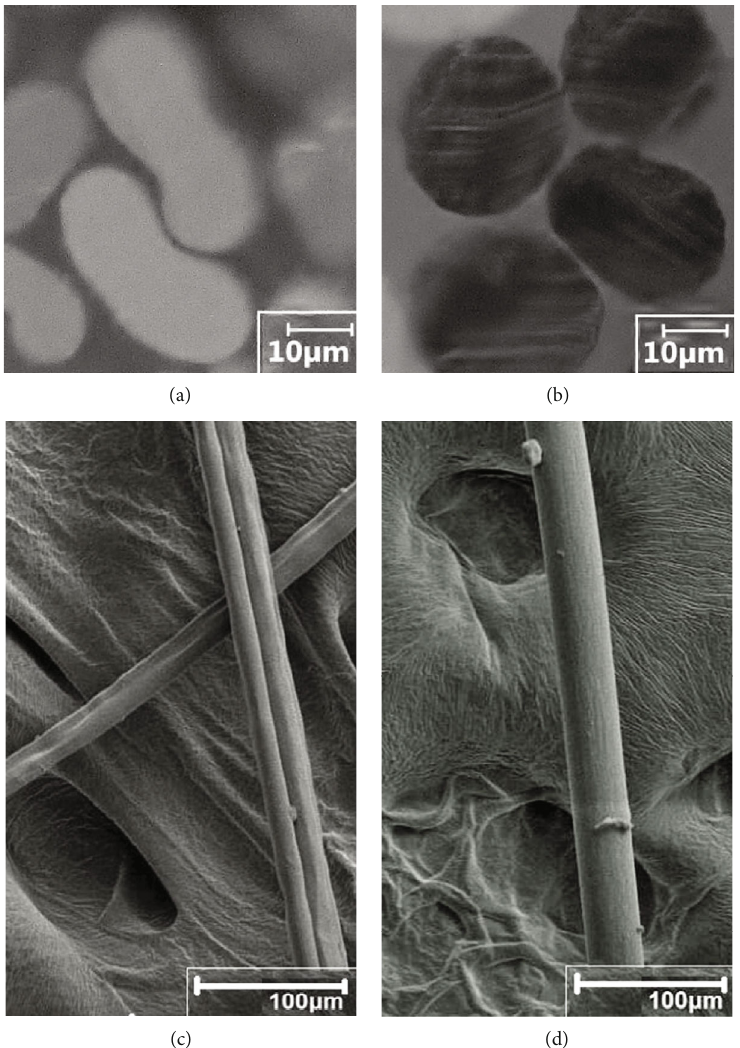
Figure 5: Longitudinal and cross-sectional morphologies of fi bers. (a) and (c) for FCOM, (b) and (d) for FPRE. (a) and (b) obtained with optical microscopy, (c) and (d) obtained with